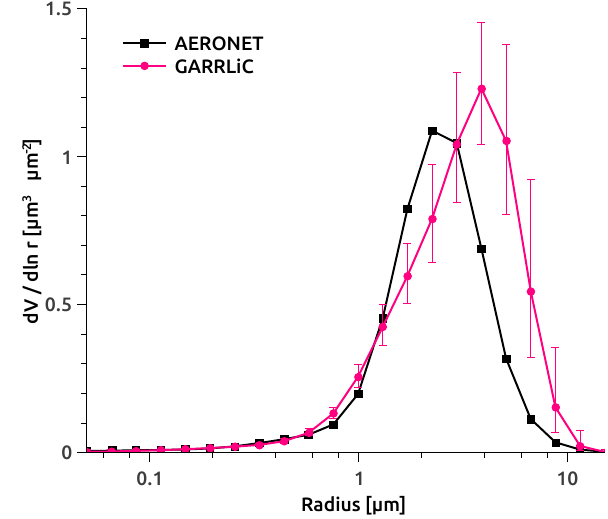
Figure 13. GARRLiC (pink) and AERONET (black) SD for 10 April 2015 (16:11UTC) over the Dakar site (AOD 440nm ≈ 1 . 53 ± 0 . 04 ; α ≈ 0 . 02 ± 0 . 01).